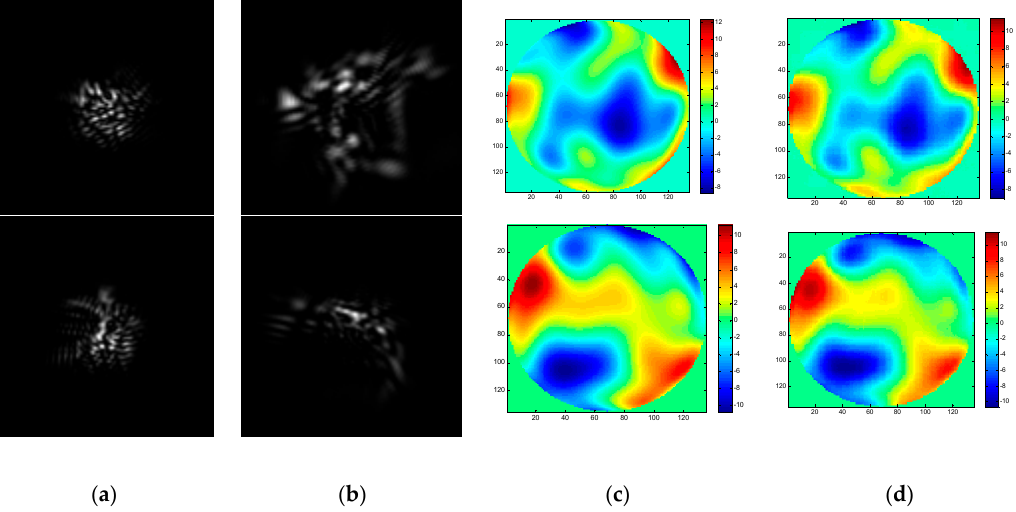
Figure 3. Predicting effect of ( a ) the initial in focus input point spread function (PSF) images; ( b ) the initial defocus PSF images; ( c ) the initial wavefront maps; ( d ) the wavefront maps by the De-VGG predicted for D/r 0 = 20.